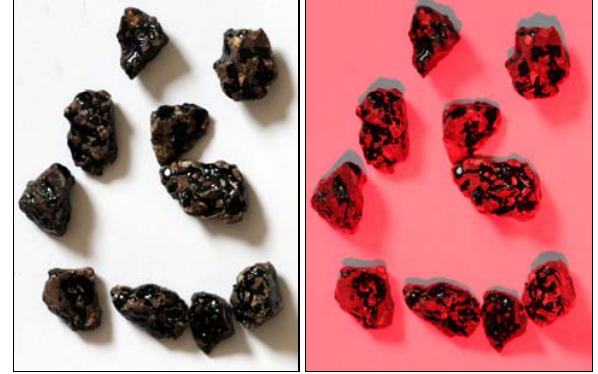
Figure 5: Image of bitumen covered aggregate taken under daylight conditions (left) and illuminated with a laser light diode (right).